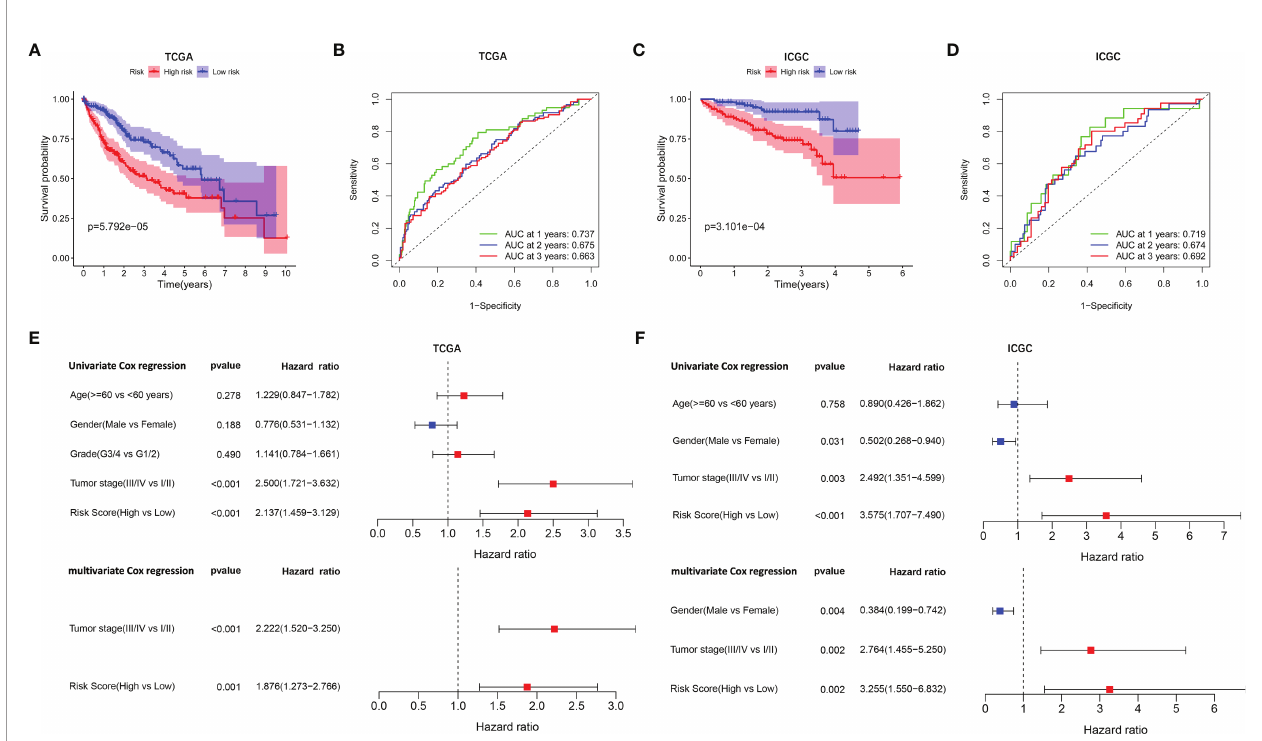
FIGURE 3 | Survival analysis and independent prognostic analysis of the prognostic signature. TCGA cohort (A, B, E) and ICGC cohort (C, D, F) . (A, C) The Kaplan – Meier plot showed overall survival between two subgroups. (B, D) ROC curves of the fi ve-gene signature for prediction of 1-, 2-, and 3-year OS. (E, F) Univariate and multivariate Cox regression analyses to screen prognostic factors for OS.